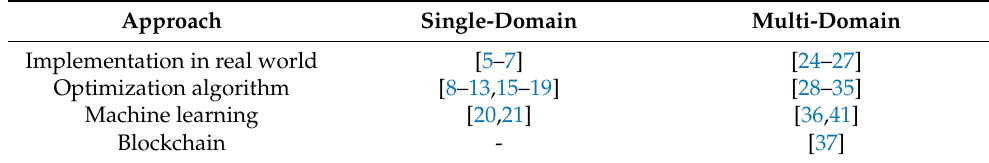
Table 1. Summary of related